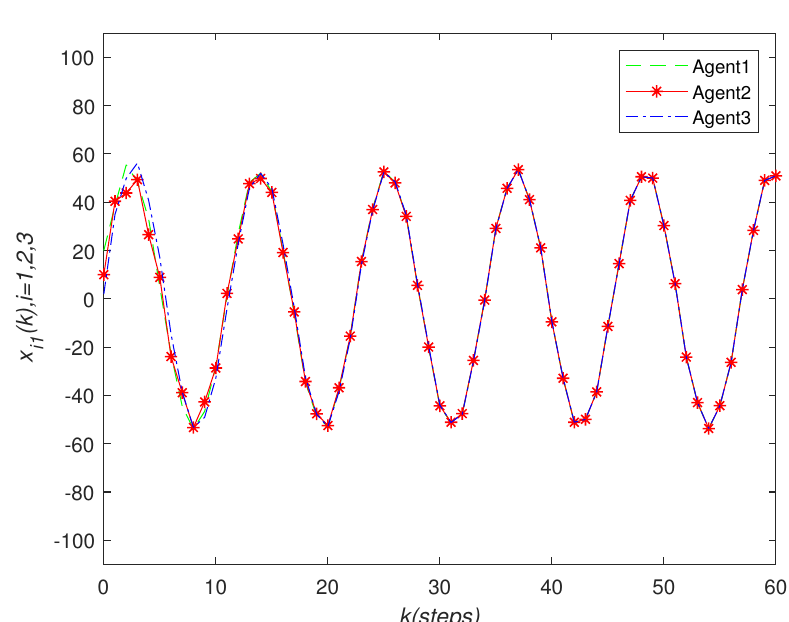
Figure 3. Communication topology of three agents.